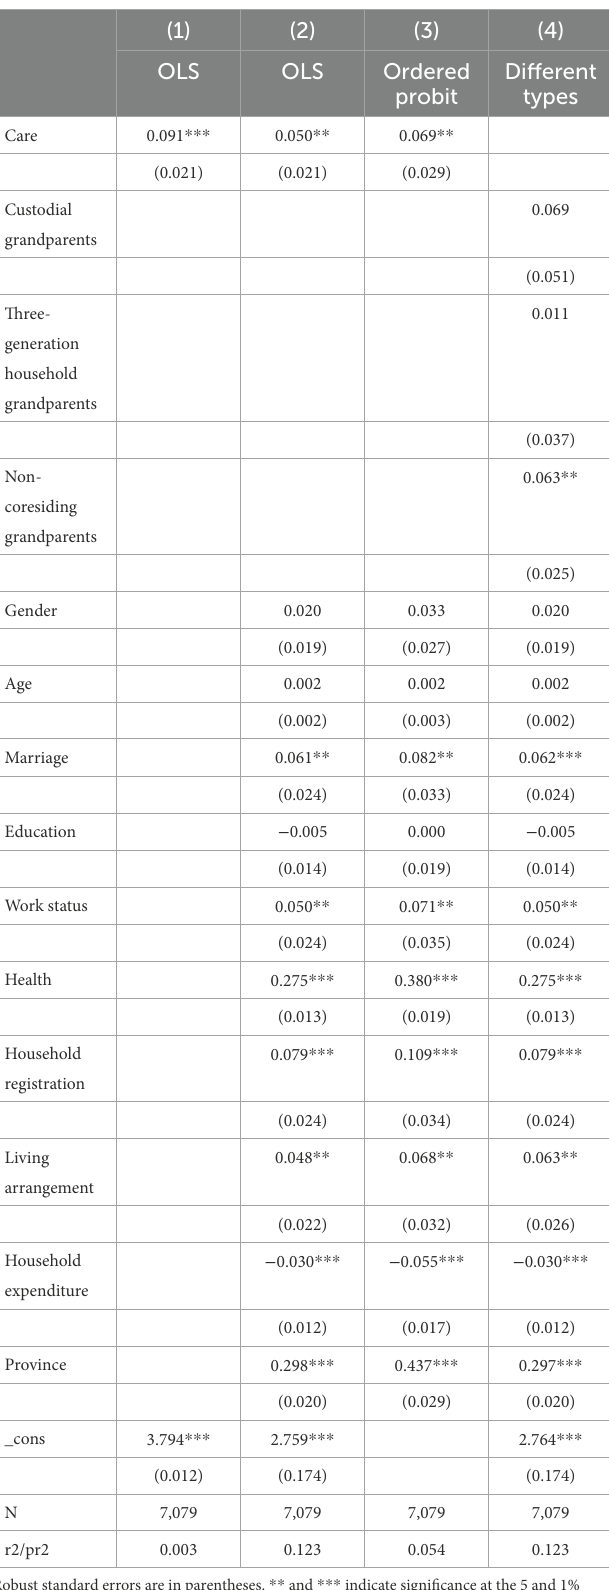
TABLE 2 Results of the benchmark